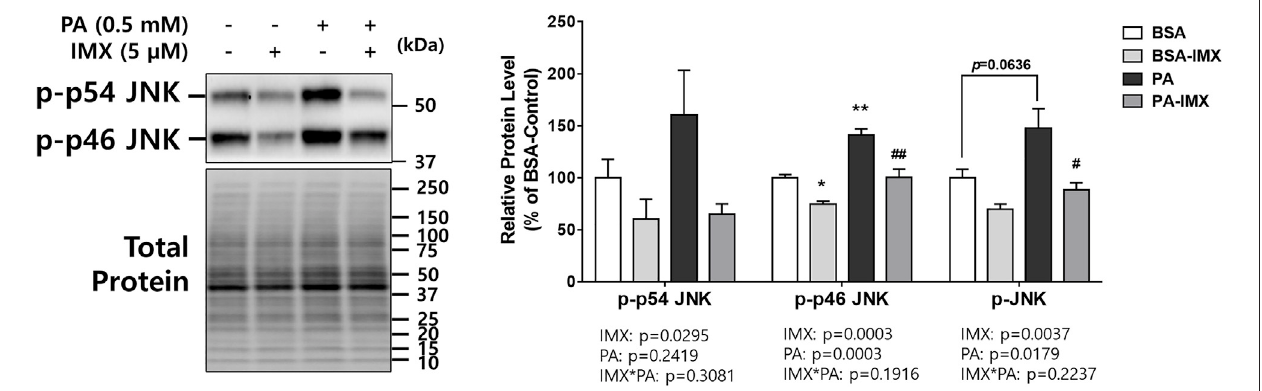
FIGURE 3 | Effect of palmitate and Imoxin on p-JNK expression in C2C12 myotubes. The cells were treated with imoxin (IMX) at 5 μ M with/without 0.5 mM palmitate (PA)for24 h. Protein level ofp-JNK(p-p54/p46)wasmeasured bywesternblot. Representativeband images areshown on theleft paneland quanti fi cation of each phosphorylation site and their summation is shown on the right panel. Differences between treatments were analyzed by two-way ANOVA (IMX x PA). Values are presented as mean ± SEM (N = 3). * p < 0.05 and ** p < 0.01 compared with the BSA-control group; # p < 0.05 and ## p < 0.01 compared with the PA only group.